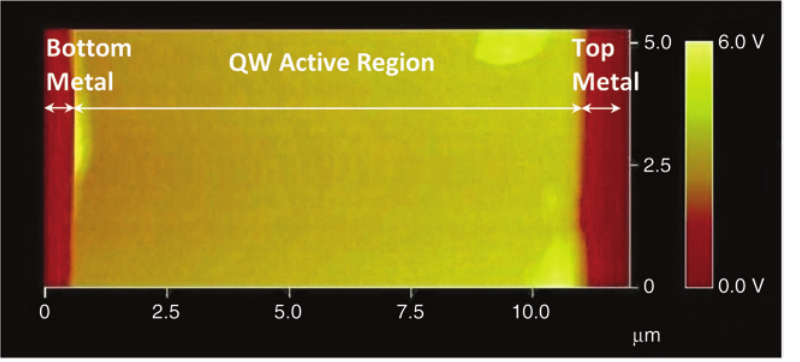
Figure 9: Four SSRM calibration curves obtained at different DC tip biases (1.0, 1.5, 2.5, and 3.5 V), correlating the SSRM measured resist- ance to the doping concentration in a GaAs standard sample with staircase doping profile. The doping concentration of the GaAs standard sample is obtained from second ion mass spectroscopy. The error bars are ± 10% and ± 5% for x - and y -axis, respectively.